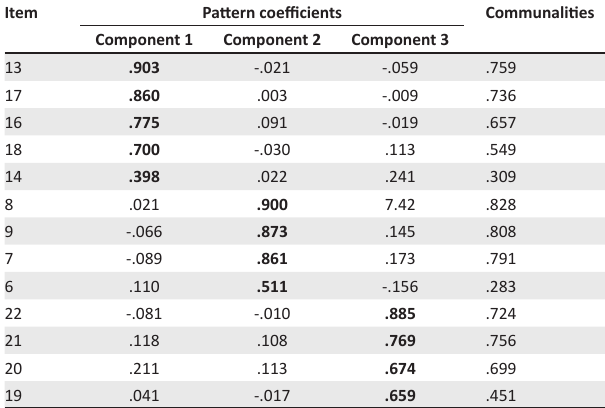
TABLE 6: Pattern matrix and communalities of the three-factor solution of administrative employee perception scale